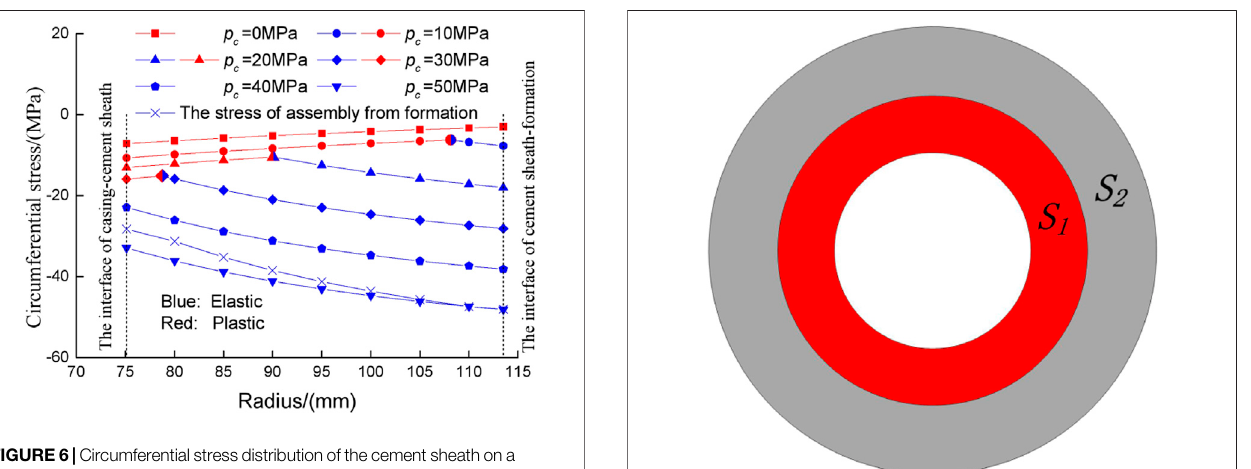
FIGURE6| Circumferential stressdistributionofthecement sheathona casing pressure of 150 MPa.